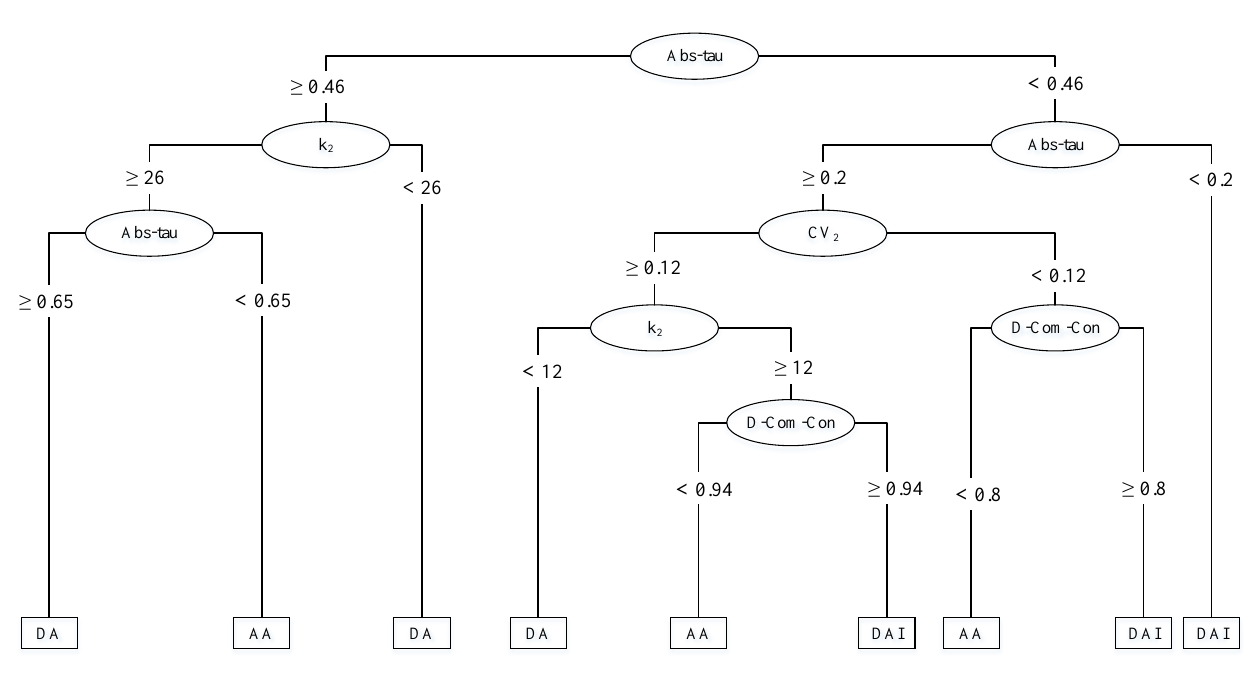
Figure 3. Classification tree obtained from adjusted parameters.